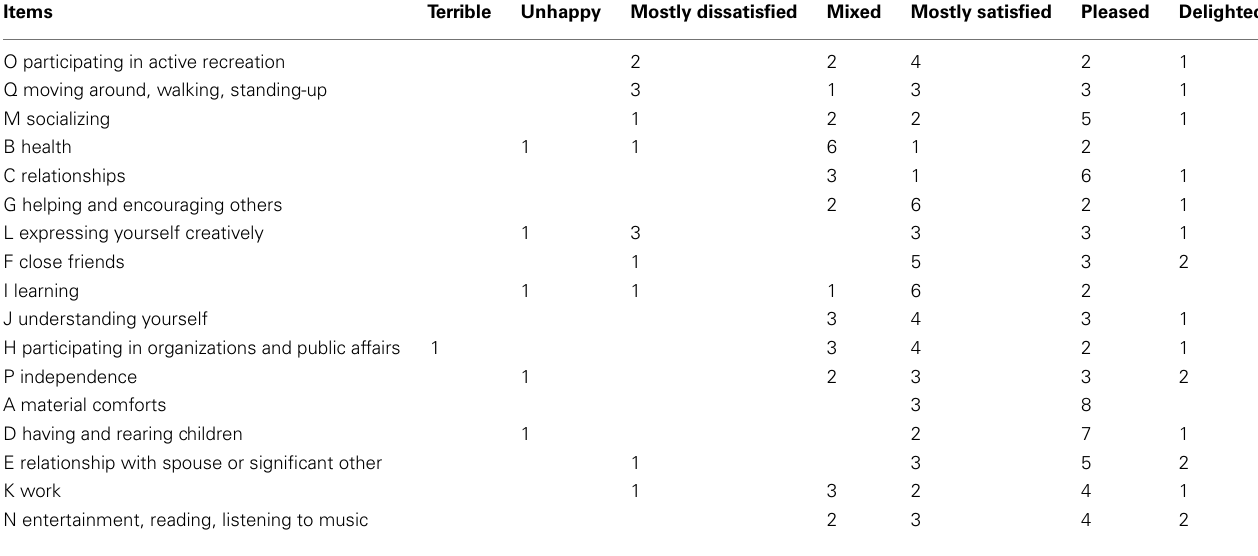
Table 4 | Quality of life scale, response